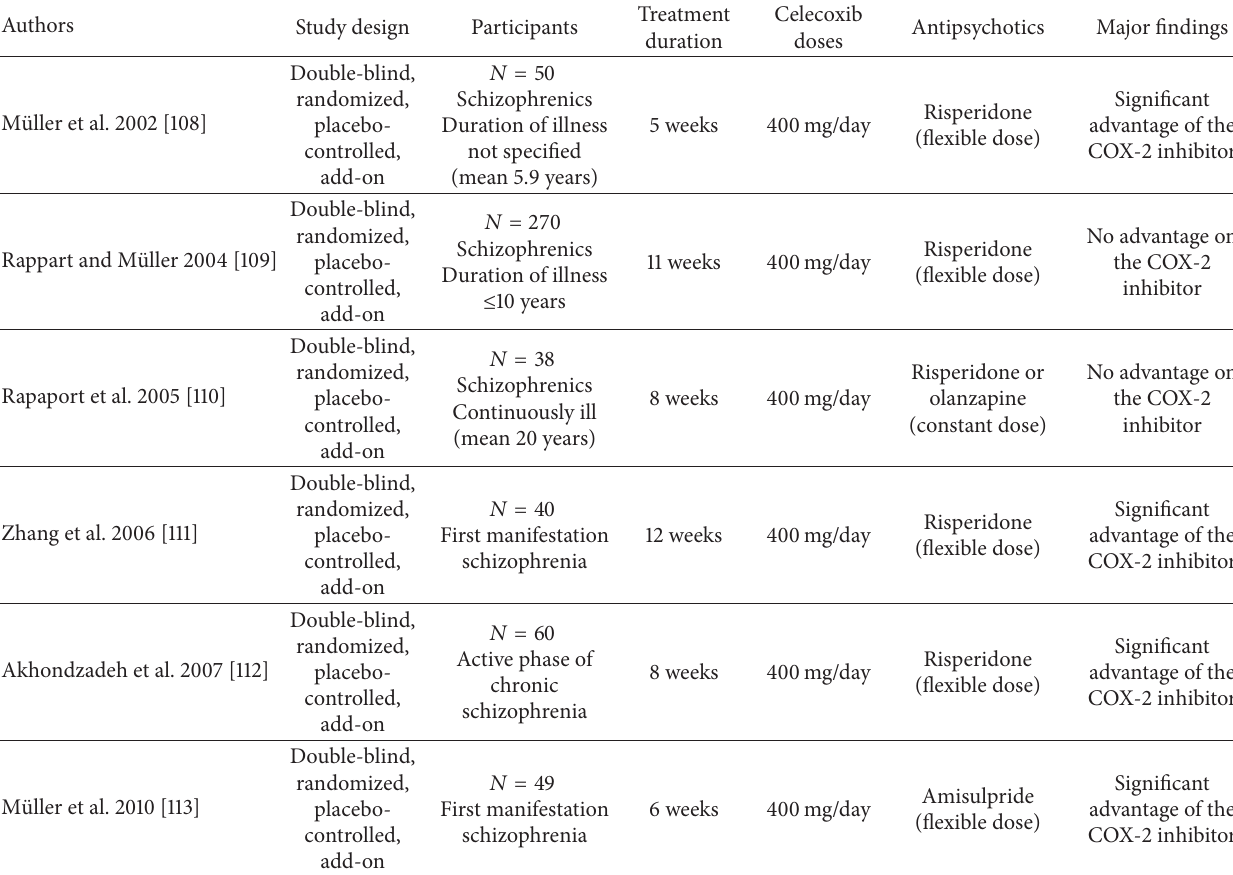
Table 1: Celecoxib randomized clinical add-on